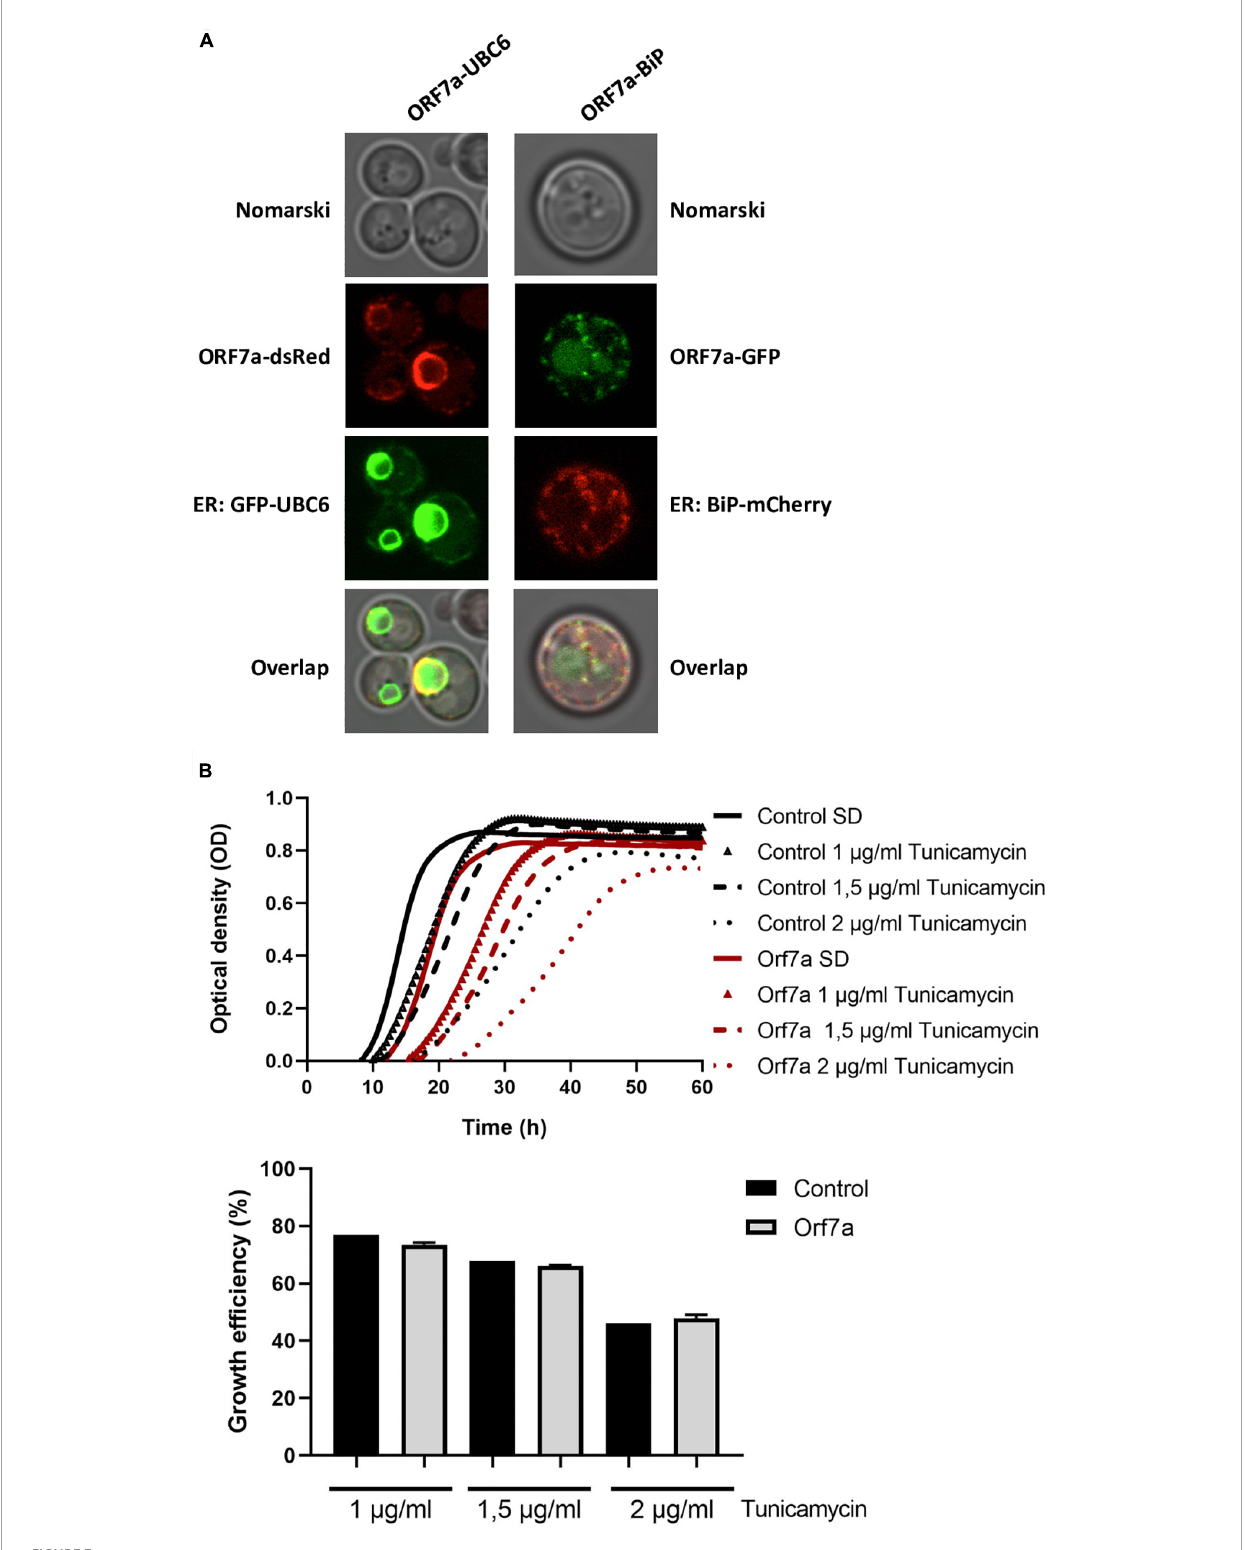
FIGURE3 Severe acute respiratory syndrome coronavirus-2 (SARS-CoV-2) ORF7a localizes to the endoplasmic reticulum (ER) in yeast cells. (A) ORF7a-GFP or ORF-7a-dsRed was constitutively overexpressed in yeast wild type cells from high copy plasmids and visualized by confocal fluorescence microscopy. GFP-Ubc6 or BiP-mCherry were co-expressed as green or red ER markers. (B) ER localization of SARS-CoV-2 ORF7a does not confer a general ER dysfunction. Constitutively ORF7a overexpressing yeast cells were treated or not with the indicated concentrations of ER inhibitor tunicamycin. Upper panel: Continuous growth curves derived from three biological replicates. Lower panel: Representation of the relative growth efficiency. Growth of the empty plasmid control cells was set to 100% for SD medium without tunicamycin. Three independent biological samples were analyzed. Data are mean ±